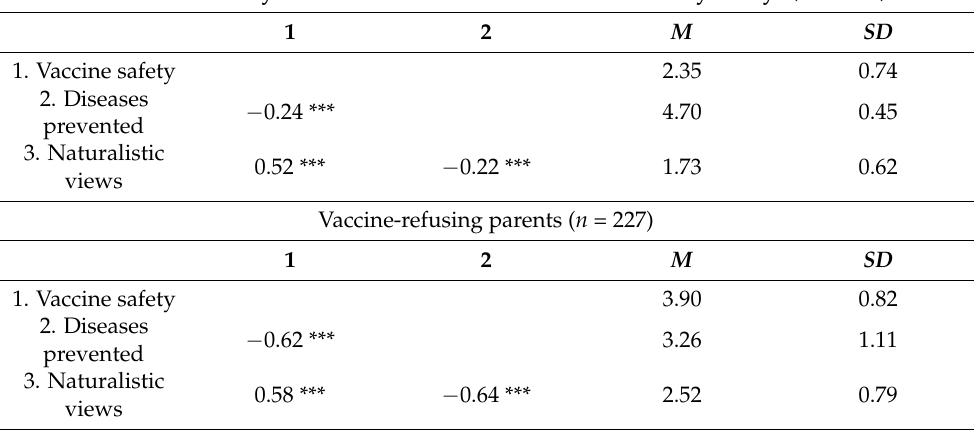
Table 2. Descriptive statistics and correlations (Study